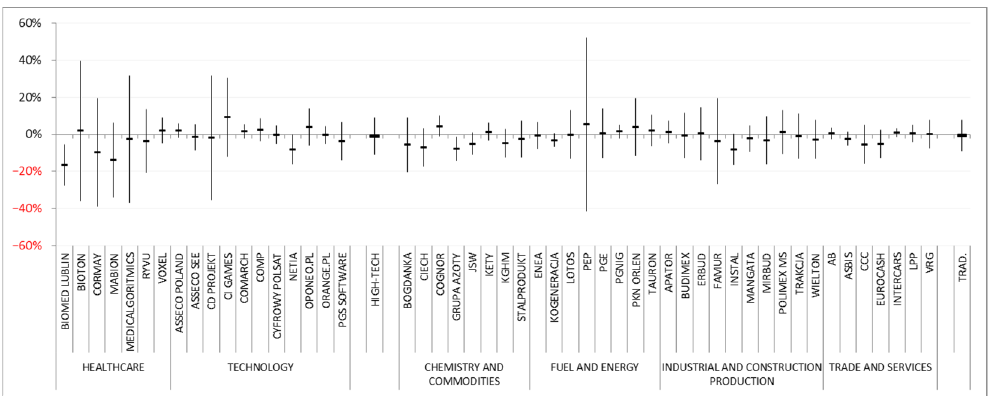
Figure 15. Typical area of total cost variation per unit of assets in the surveyed enterprises. Source: own work.